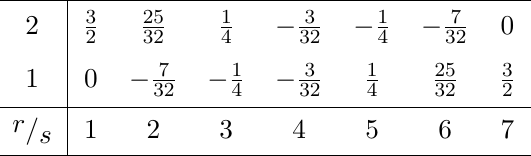
Table 15 . The generators of the defect classifying algebra of FM (4 ; 5).